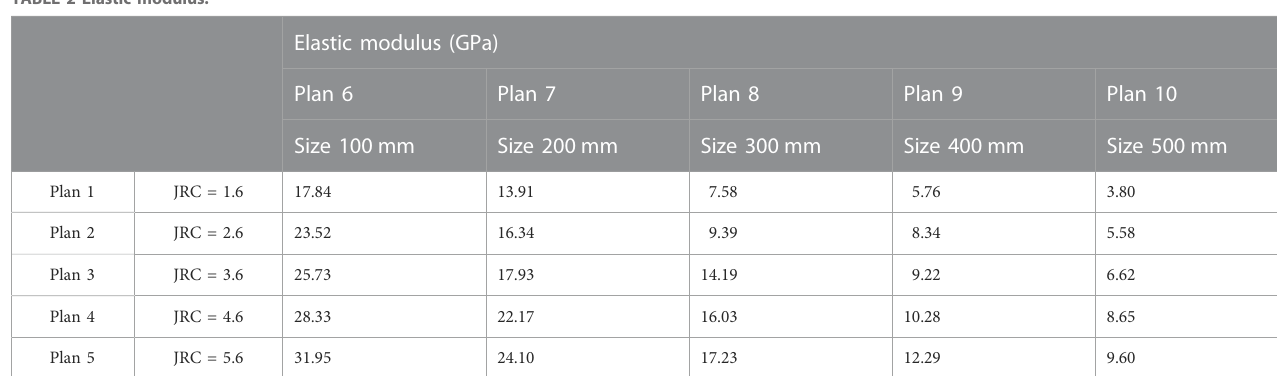
TABLE 2 Elastic